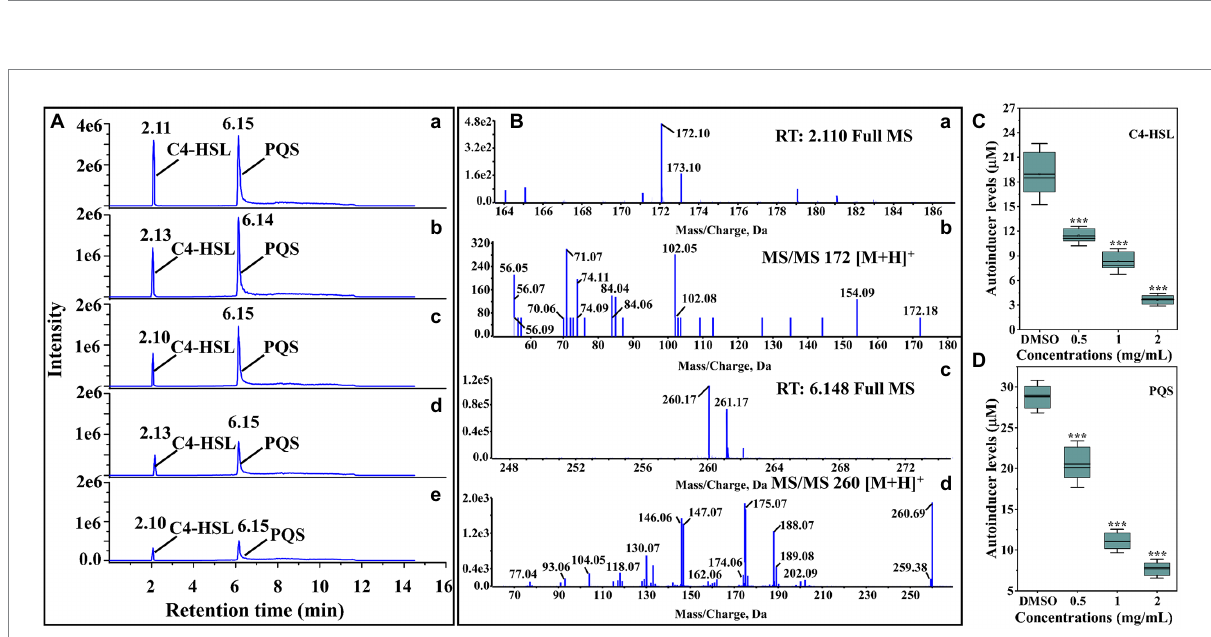
FIGURE 2 Identification and quantification of C4-HSL and PQS by LC–MS/MS chromatograms. (A) HPLC chromatograms of C4-HSL and PQS secreted by P. aeruginosa PAO1 supplemented with (b) DMSO, (c) 0.5, (d) 1, and (e) 2 mg/ml of thymoquinone. (a) Standard chemicals of C4-HSL and PQS. (B) MS and MS/MS spectra of C4-HSL and PQS, respectively: (a) full MS spectra of C4-HSL, (b) MS 2 spectra of C4-HSL, (c) full MS of PQS, (d) MS 2 spectra of PQS. (C) Quantitative analysis of C4-HSL treated with 0.5 to 2 μ l/ml of thymoquinone. (D) Quantitative analysis of PQS treated with 0.5 to 2 μ l/ml of